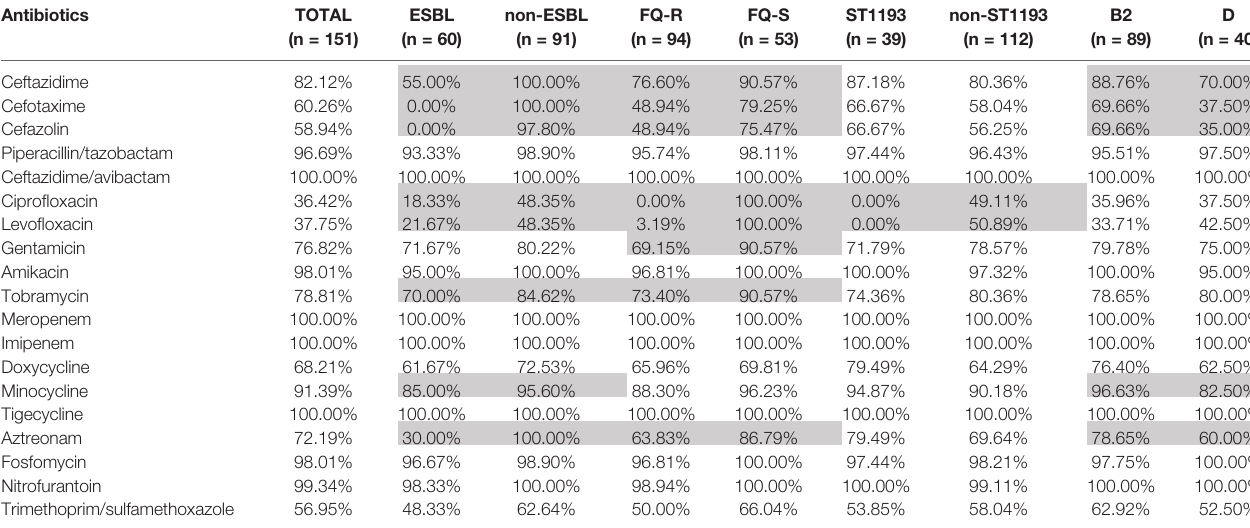
TABLE 1 | Antibiotic susceptible rates of 151 UPEC